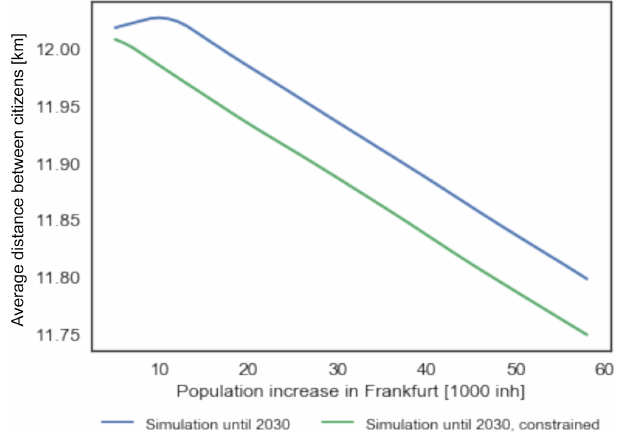
Figure 4. Moving average (five model steps) of the average dis- tance between citizens along the model runs minimizing the energy consumption for urban mobility in